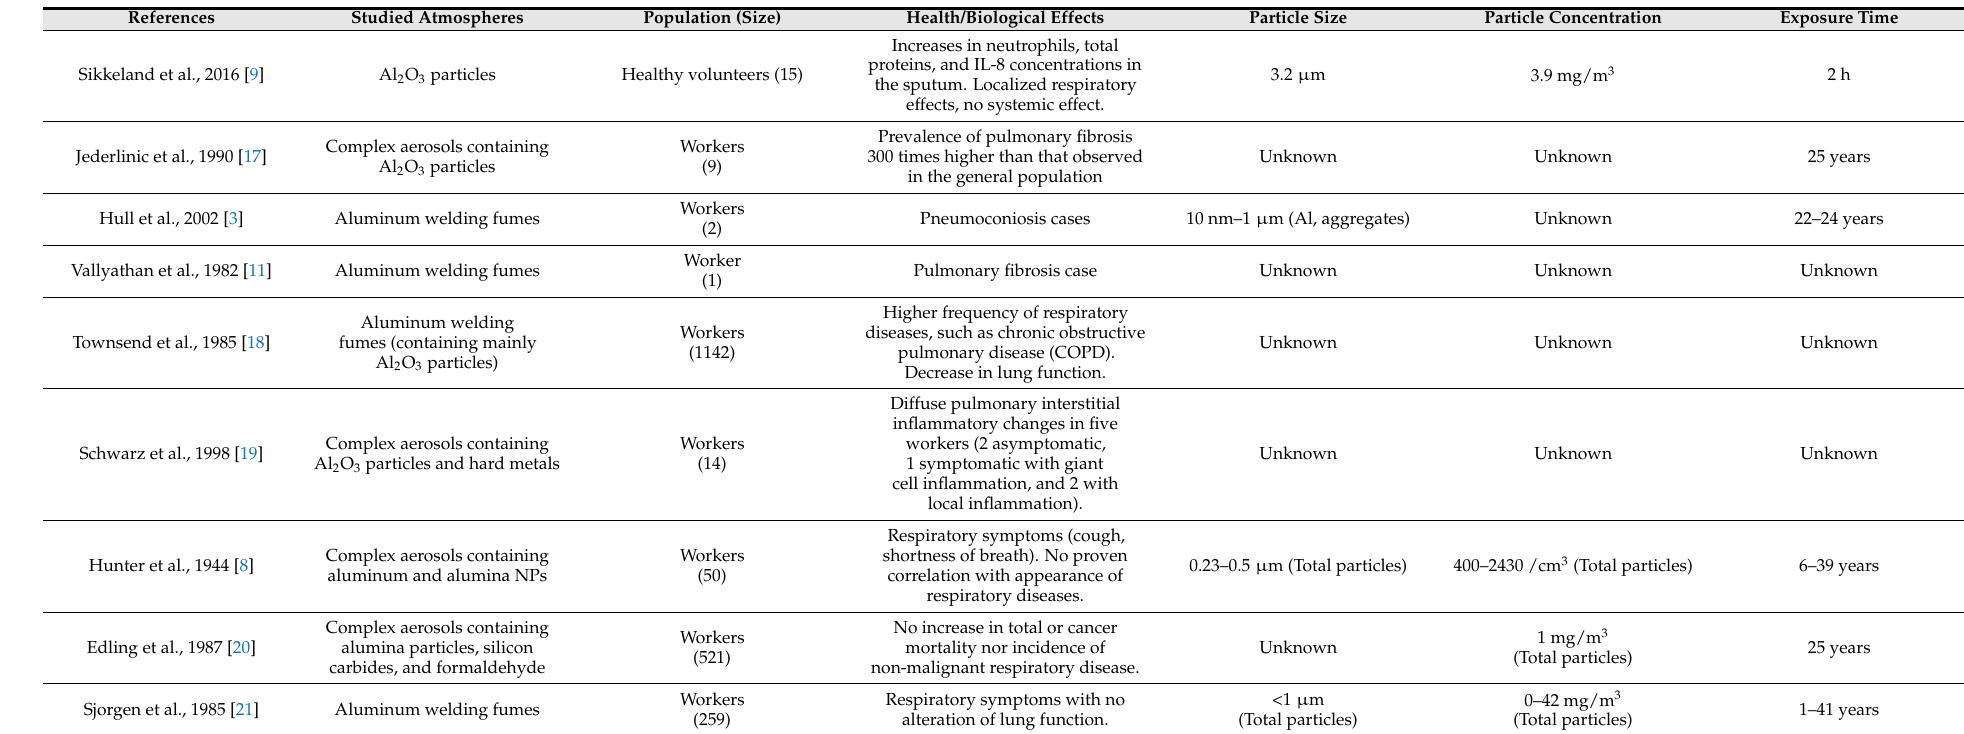
Table 1. Summary of clinical studies on health effects after inhalation of alumina